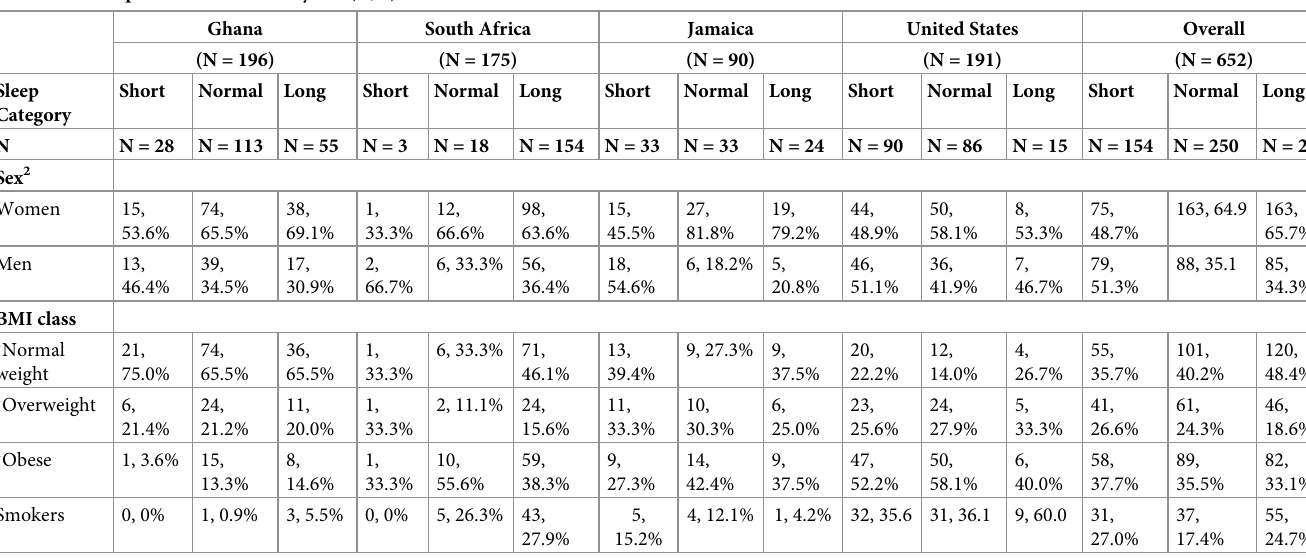
Table 2. Participant characteristics by site